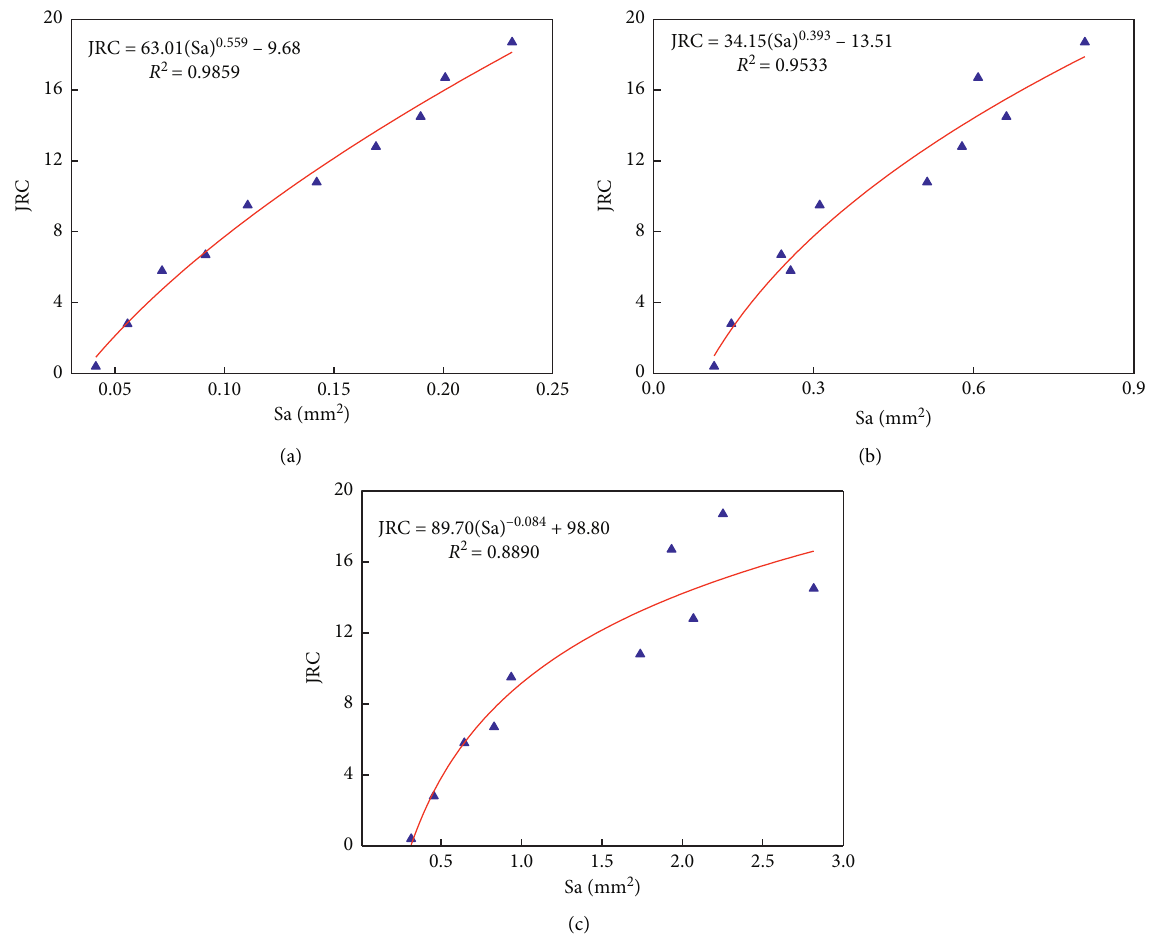
Figure 12: Fitting curves between statistical parameters and JRC. (a) 1.0mm sampling interval. (b) 2.0 mm sampling interval. (c) 4.0mm sampling